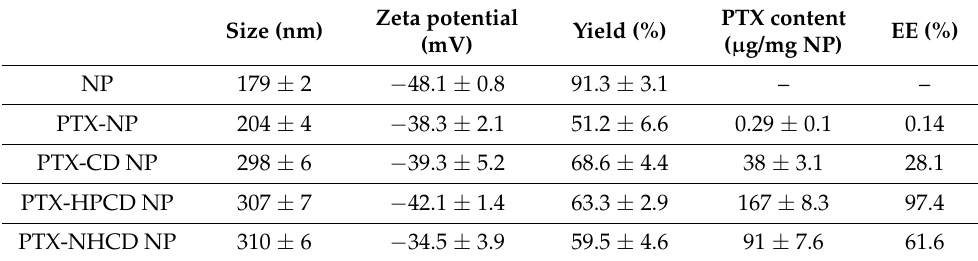
Table 1. Physico-chemical characterization of PTX-loaded poly(anhydride) nanoparticles. Experi- mental conditions: poly(anhydride): 100 mg; paclitaxel: 10 mg; PTX–cyclodextrin stoichiometry: